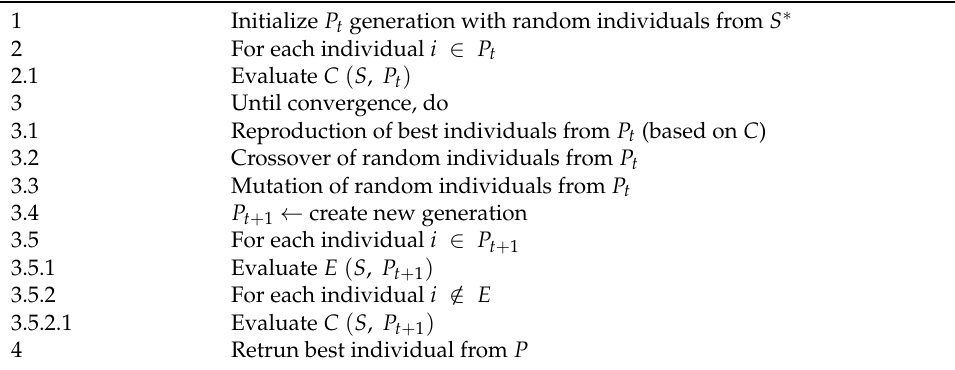
Table 4. Pseudocode of the genetic